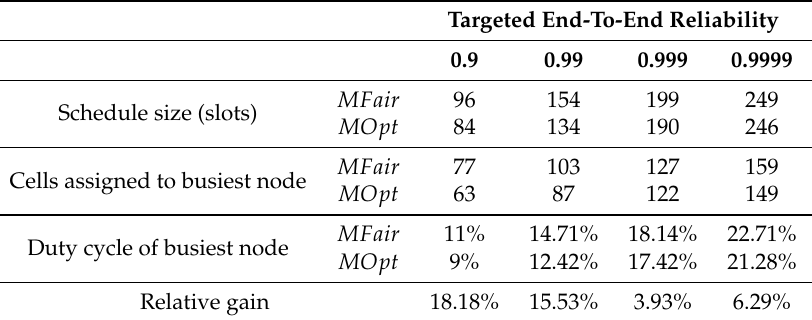
Table 11. Comparison of the duty cycle of the busiest node for MFair and MOpt